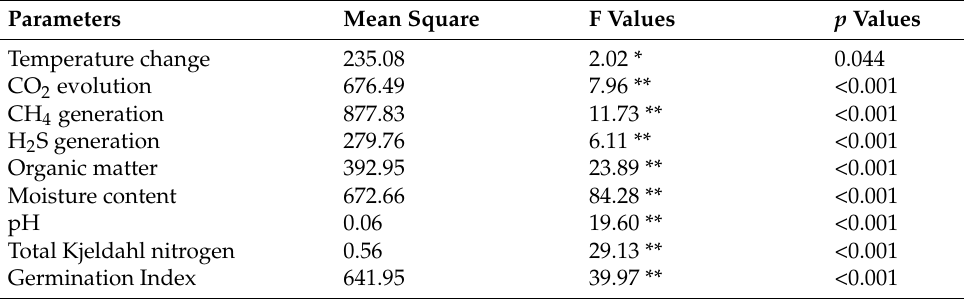
Table 2. Analysis of variance with probability ( p values) for composting parameters affected by various rates of inorganic porous bulking agents expanded perlite and